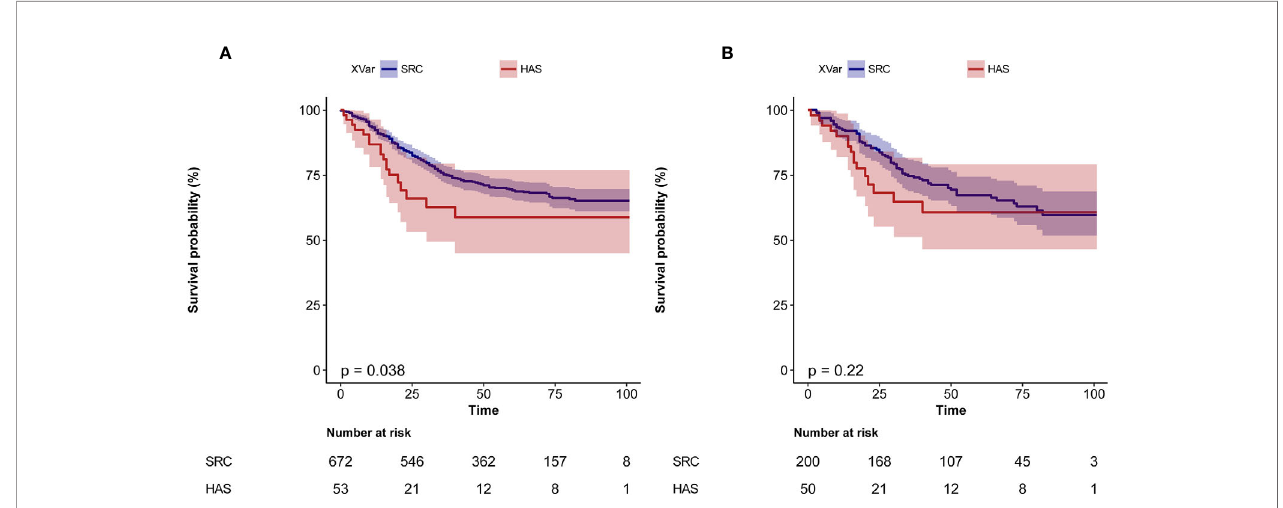
FIGURE 2 | Kaplan – Meier curves for overall survival according to lymph node ratio. (A) Before PSM. (B) After PSM.